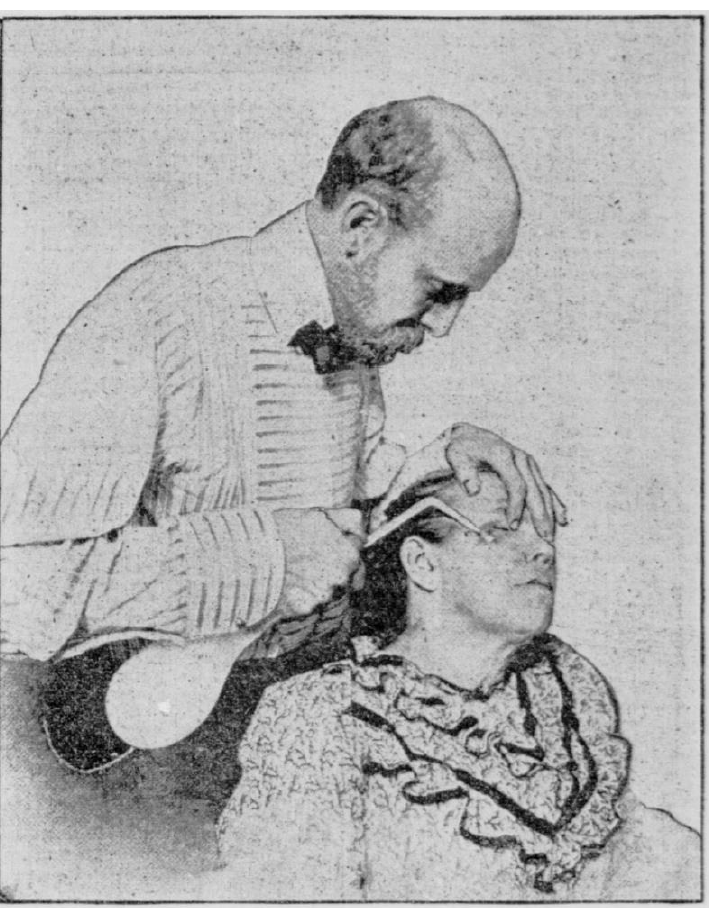
Figure 3. Campbell White treating a skin lesion with sprayed liquid air as it appeared in the New York Tribune in 1900 (reproduced from the Library of Congress, Washington, DC. New York Daily Tribune, October 25, 1900, page 8, image 22. In the public domain).